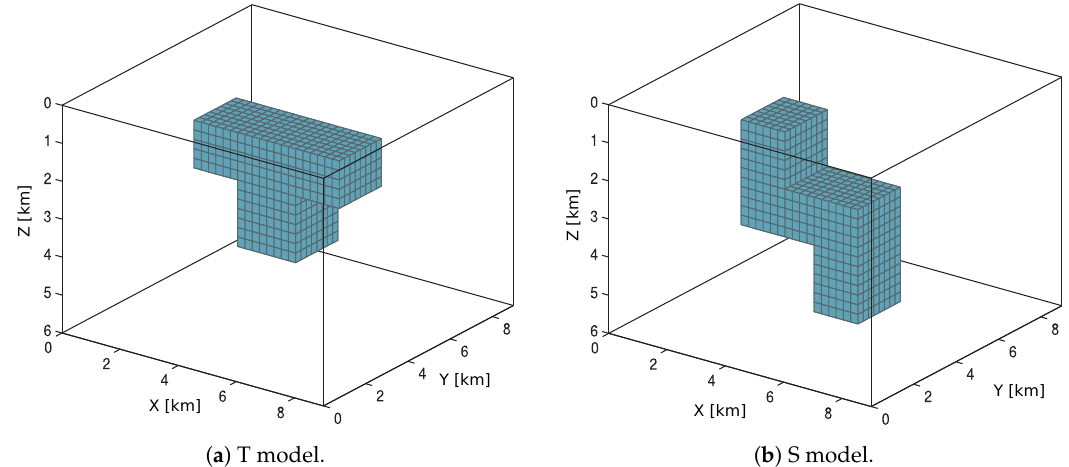
Figure 5. Considered synthetic models used for the computation of field